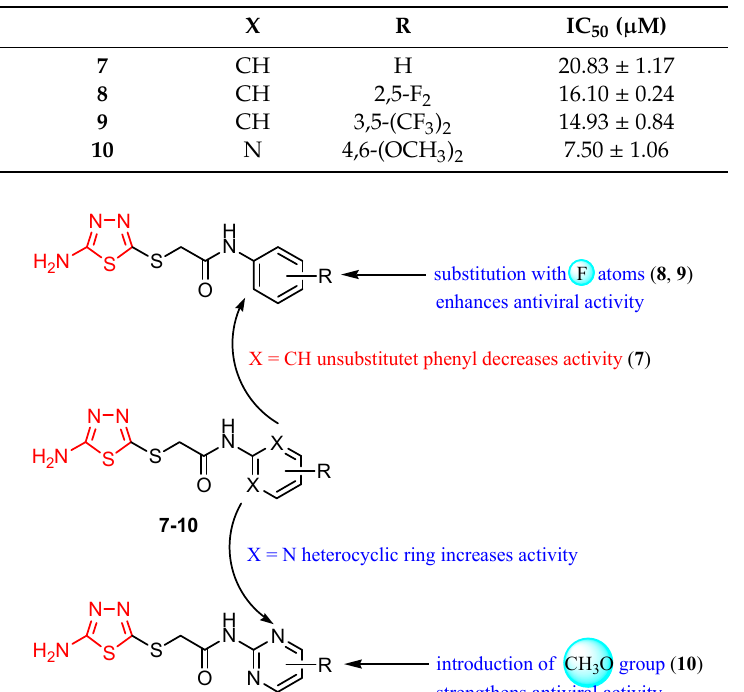
Figure 2. The influence of substituents of 1,3,4-thiadiazole derivatives 7 – 10 on anti-HIV activity.